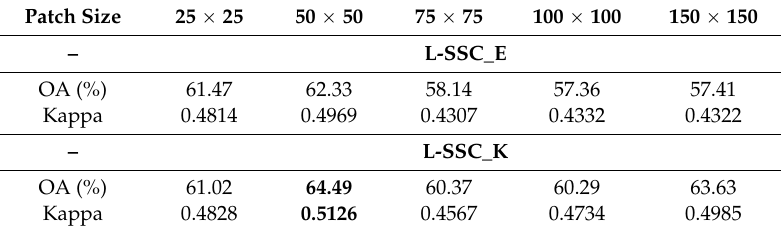
Table 9. The clustering accuracy of different patch sizes for the Indian Pine AVIRIS